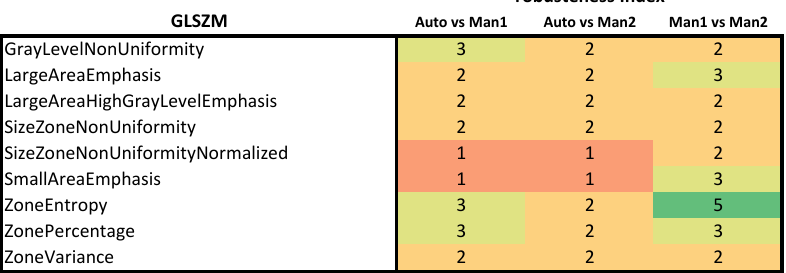
Figure 9. Robustness of the GLSZM radiomic features obtained on DCE-MRI images using automated segmentation against two manual segmentations from two independent readers.